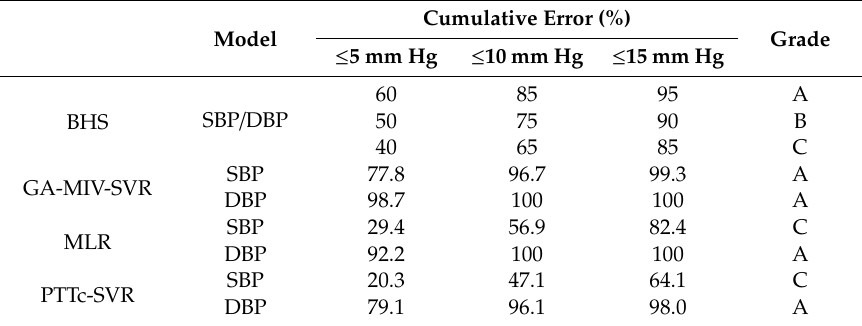
Table 6. Grading of British Hypertension Society (BHS) system and the grades of different models based on the cumulative error.